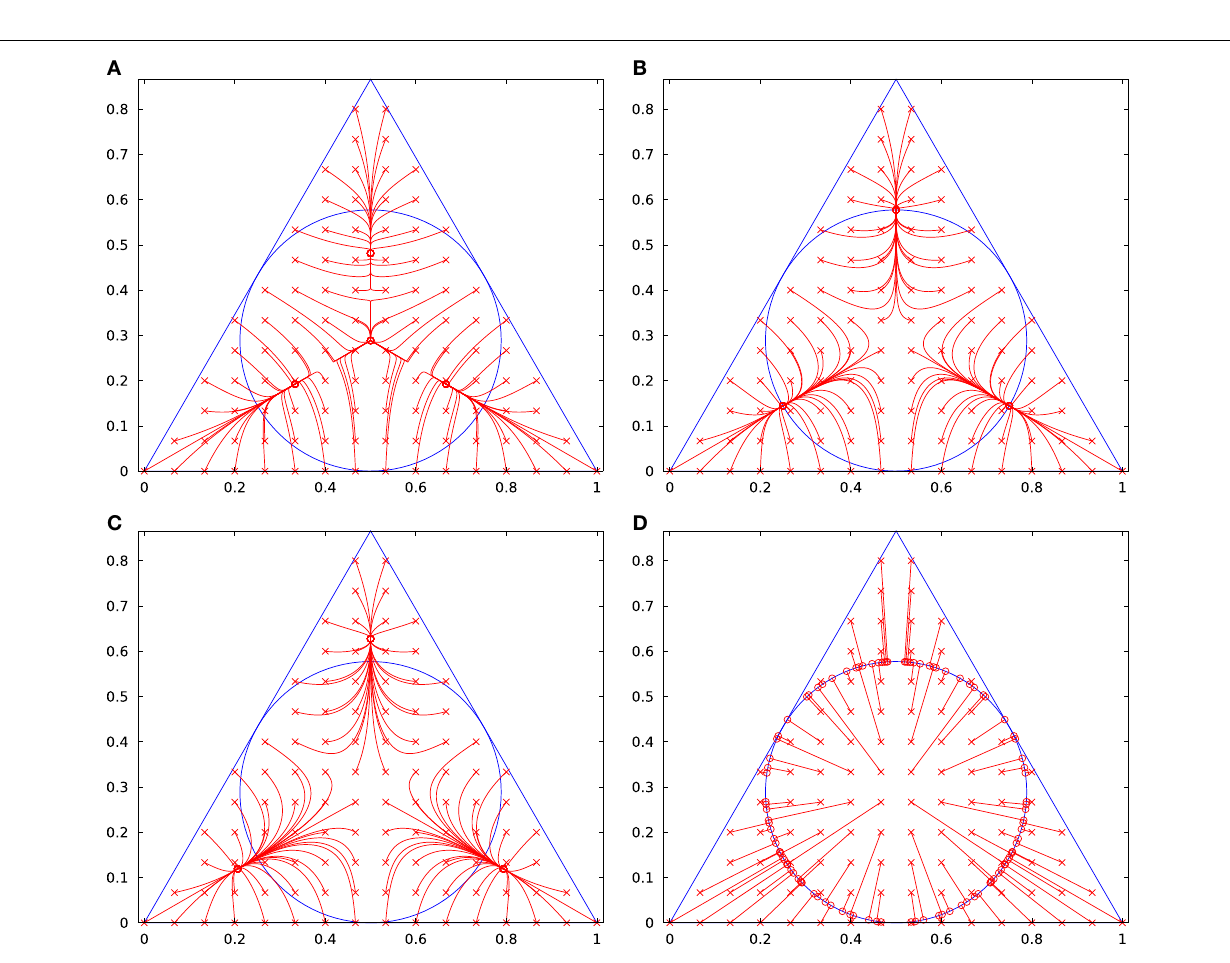
Fr ontiers in Robotics and AI |